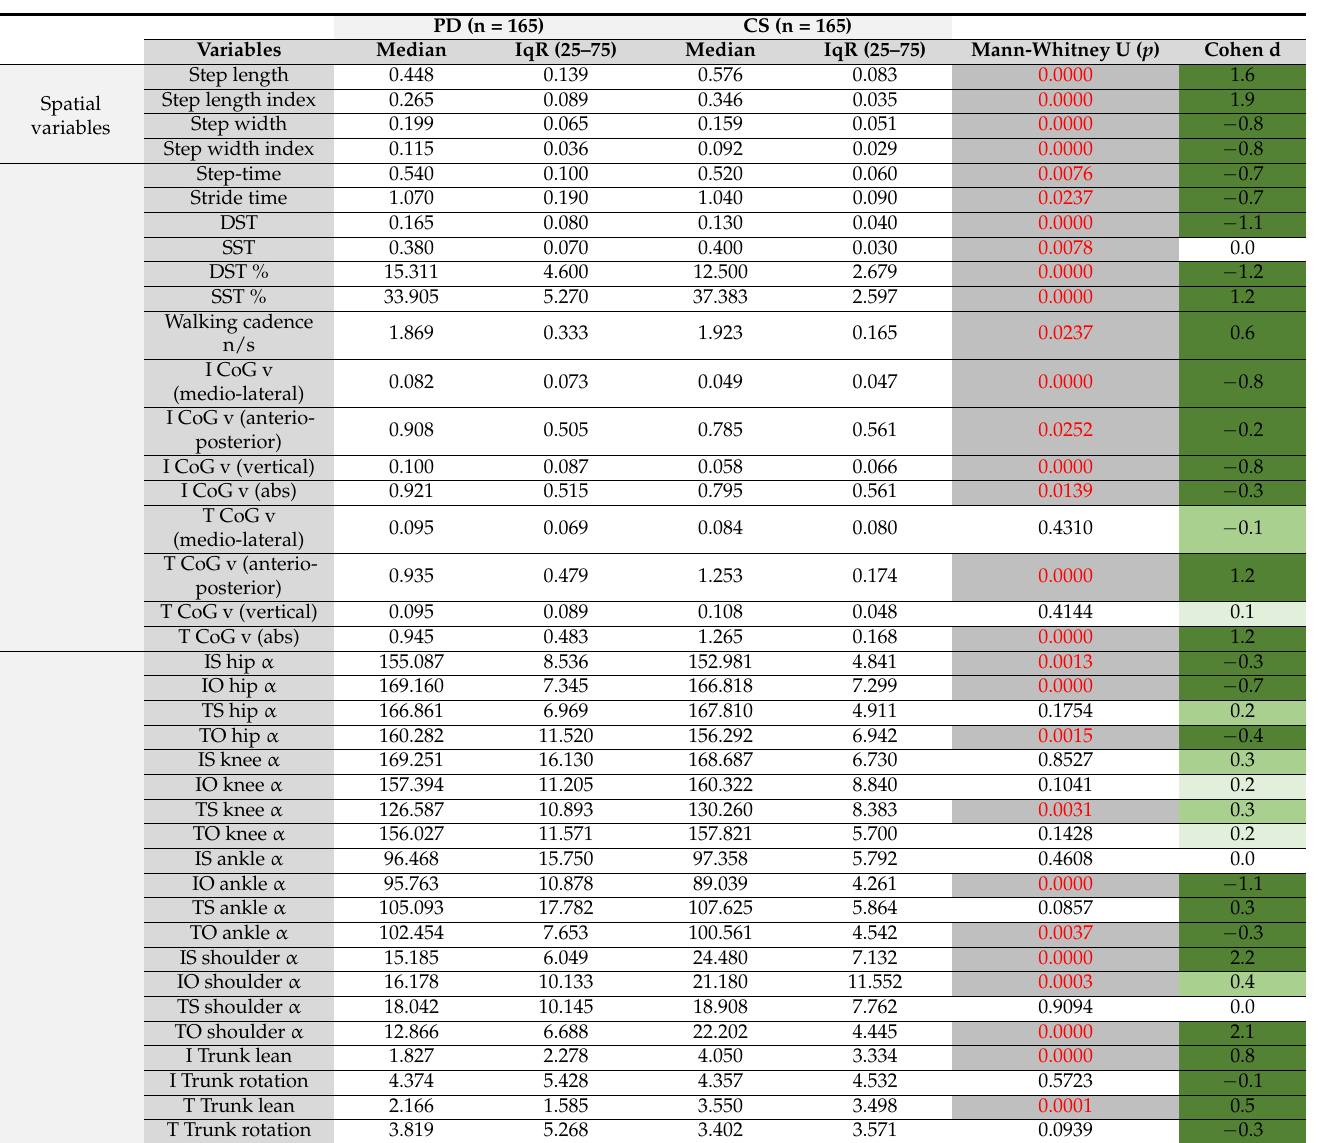
Table 1. Analysed spatial, temporal, and angular data of Parkinson’s disease (PD) and control sample (CS) groups. The spatial variables are in cm, the indexes are dimensionless. The temporal variables are in s, the indexes are in %, the cadence is in n/s. The angular variables are in ◦ . IqR stands for interquartile